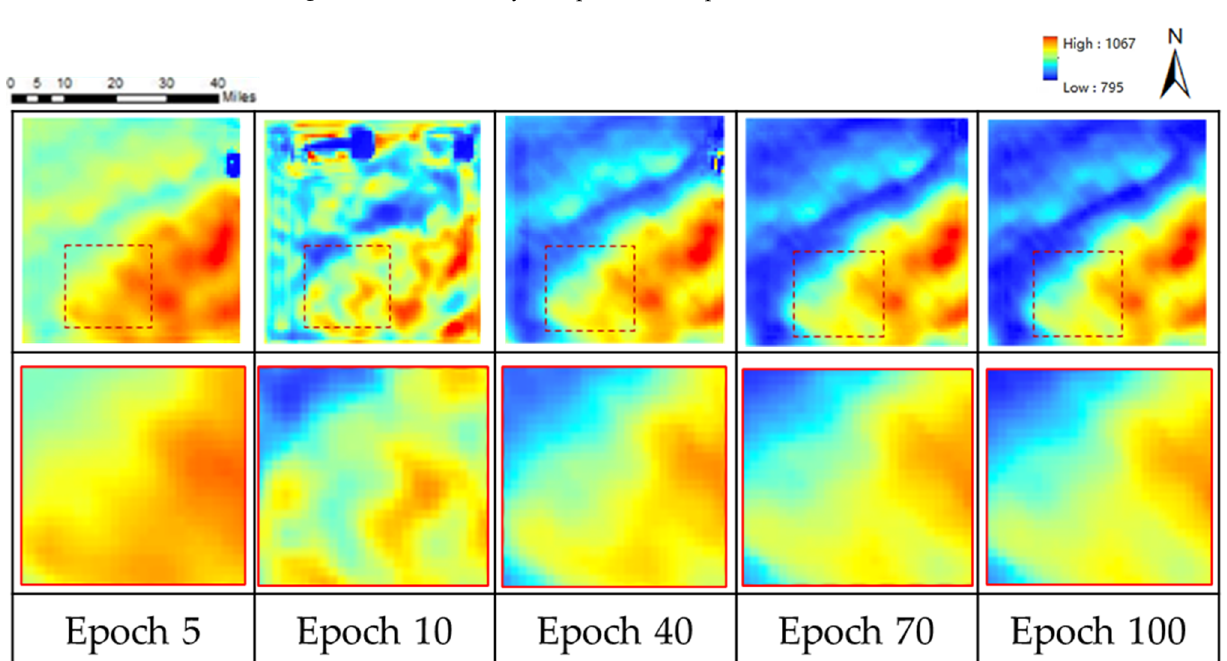
Figure 9. Unsatisfactory interpolation sample.